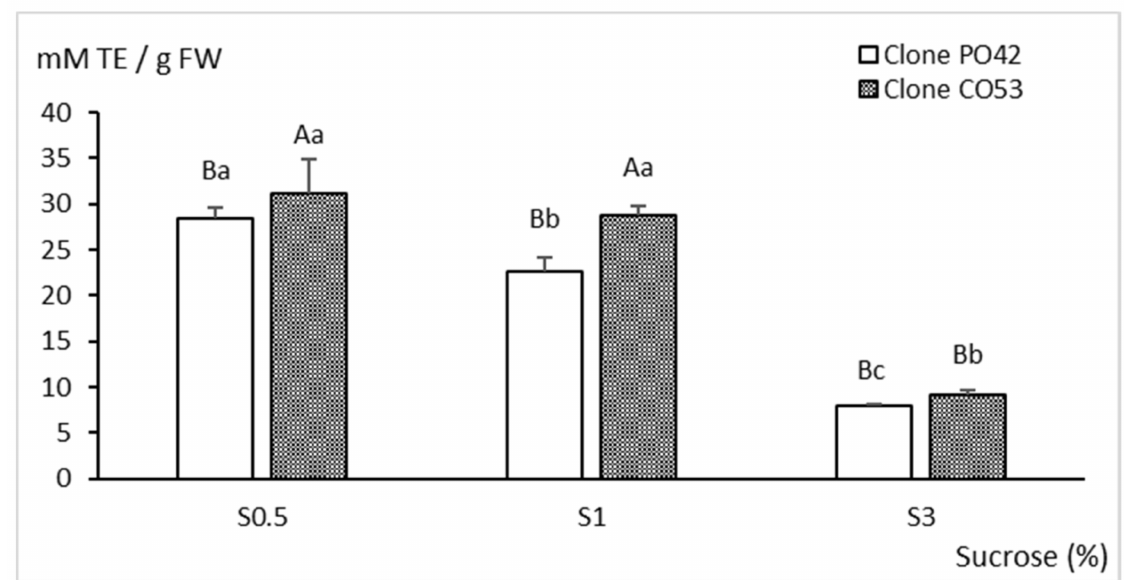
Figure 7. Effect of sucrose supplementation on antioxidant activity of shoots of clones PO42 and CO53 cultured by temporary and continuous immersion, respectively. Values are the mean ± standard error from 24 shoots analyzed independently. Different capital letters indicate significant differences in relation to the genotype, and different lowercase letters indicate significant differences in relation to the sucrose supplementation ( p < 0.05). TE: Trolox equivalents.